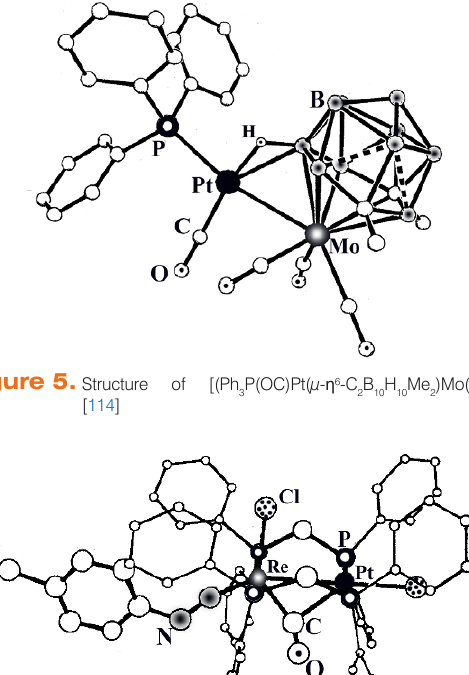
Figure 6. Structure of [ClPt(μ-CO)(μ- η 2 -dppm) Cl] [145] Figure 7. Structure of [(2,6-xylylNC)Pt(μ- η 2 -O(Me)Si(OMe) dppm)Fe(CO) 3+ [158]